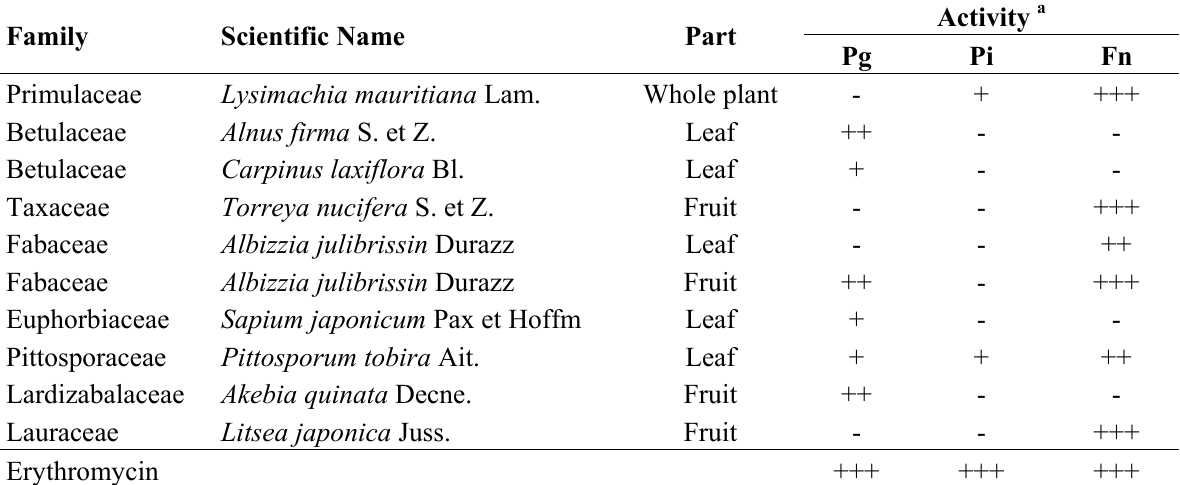
Table 1. Antibacterial activity of Korean local plant extracts against representative periodontopathic bacteria.